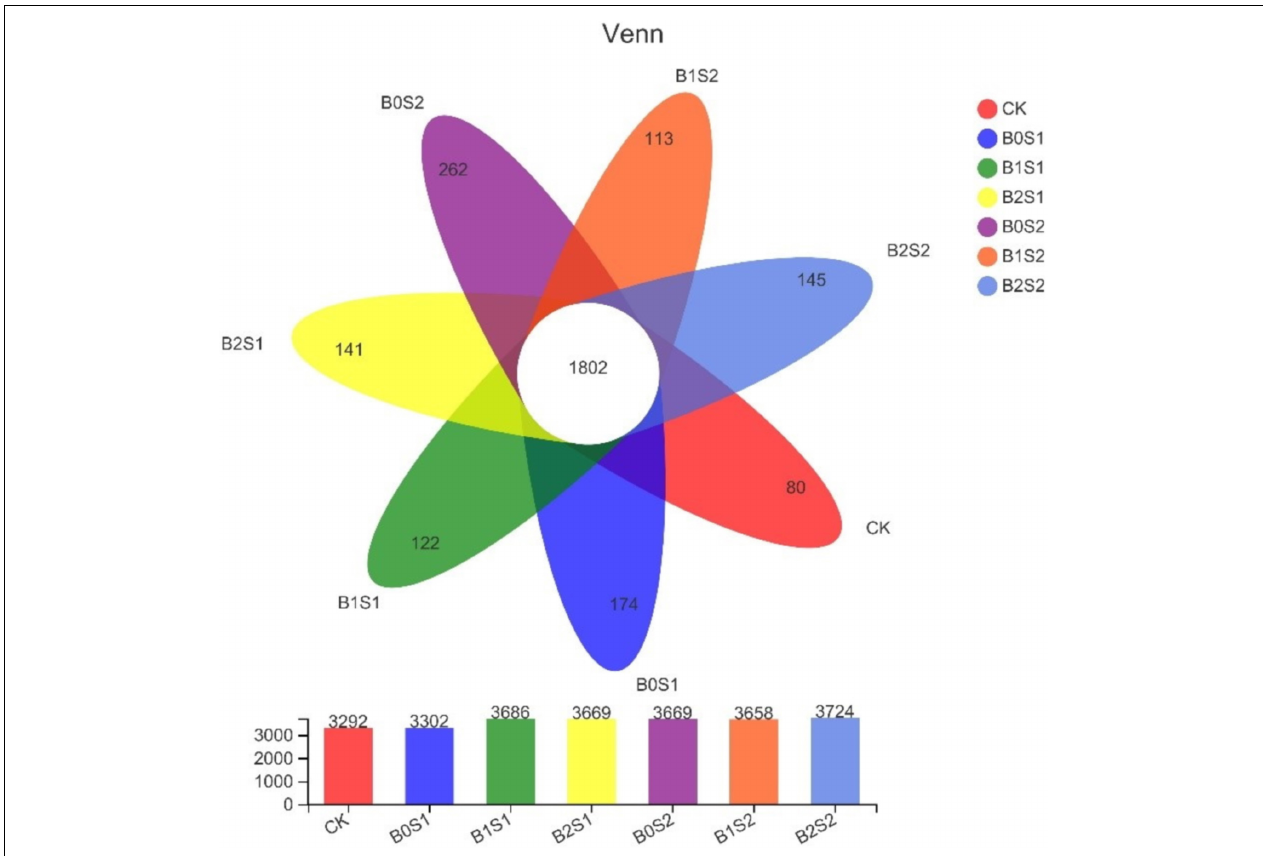
FIGURE 3 | Venn diagram analysis of abundant and showing shared operational taxonomic units. Data are presented mean; CK = control, B0S1, B1S1, B2S1, B0S2, B10S2, and B2S2 = 0, 15, and 30 g biochar + 0.5 and 1 g salt g kg − 1 respectively. TABLE 2 | Effect of acidic biochar on Ace and Chao1 richness and Shannon and Simpson diversity and Good’s coverage (%). Treatments Richness Alpha Diversity Coverage (%) Ace 1 Chao1 Shannon